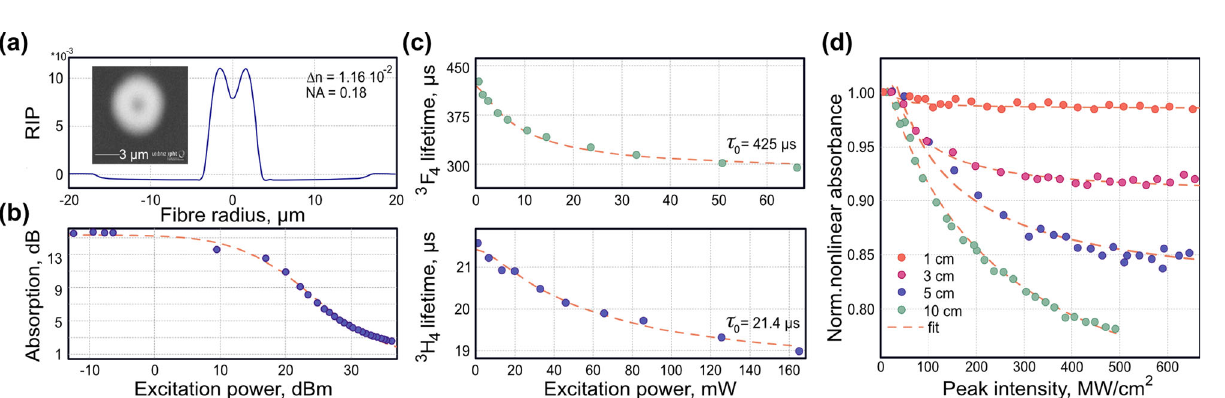
Fig. 1 Tm-doped fi bre parameters. a Refractive index pro fi le (RIP). Inset: Scanning electron microscopy image of the fi bre core; b pump saturable absorption of 18-cm fi bre section at 1550 nm. c Fluorescent lifetime of the 3 H 4 and 3 F 4 manifold against pump power for 1.5-mm fi bre length; d normalised nonlinear absorption for four length of the Tm-doped fi